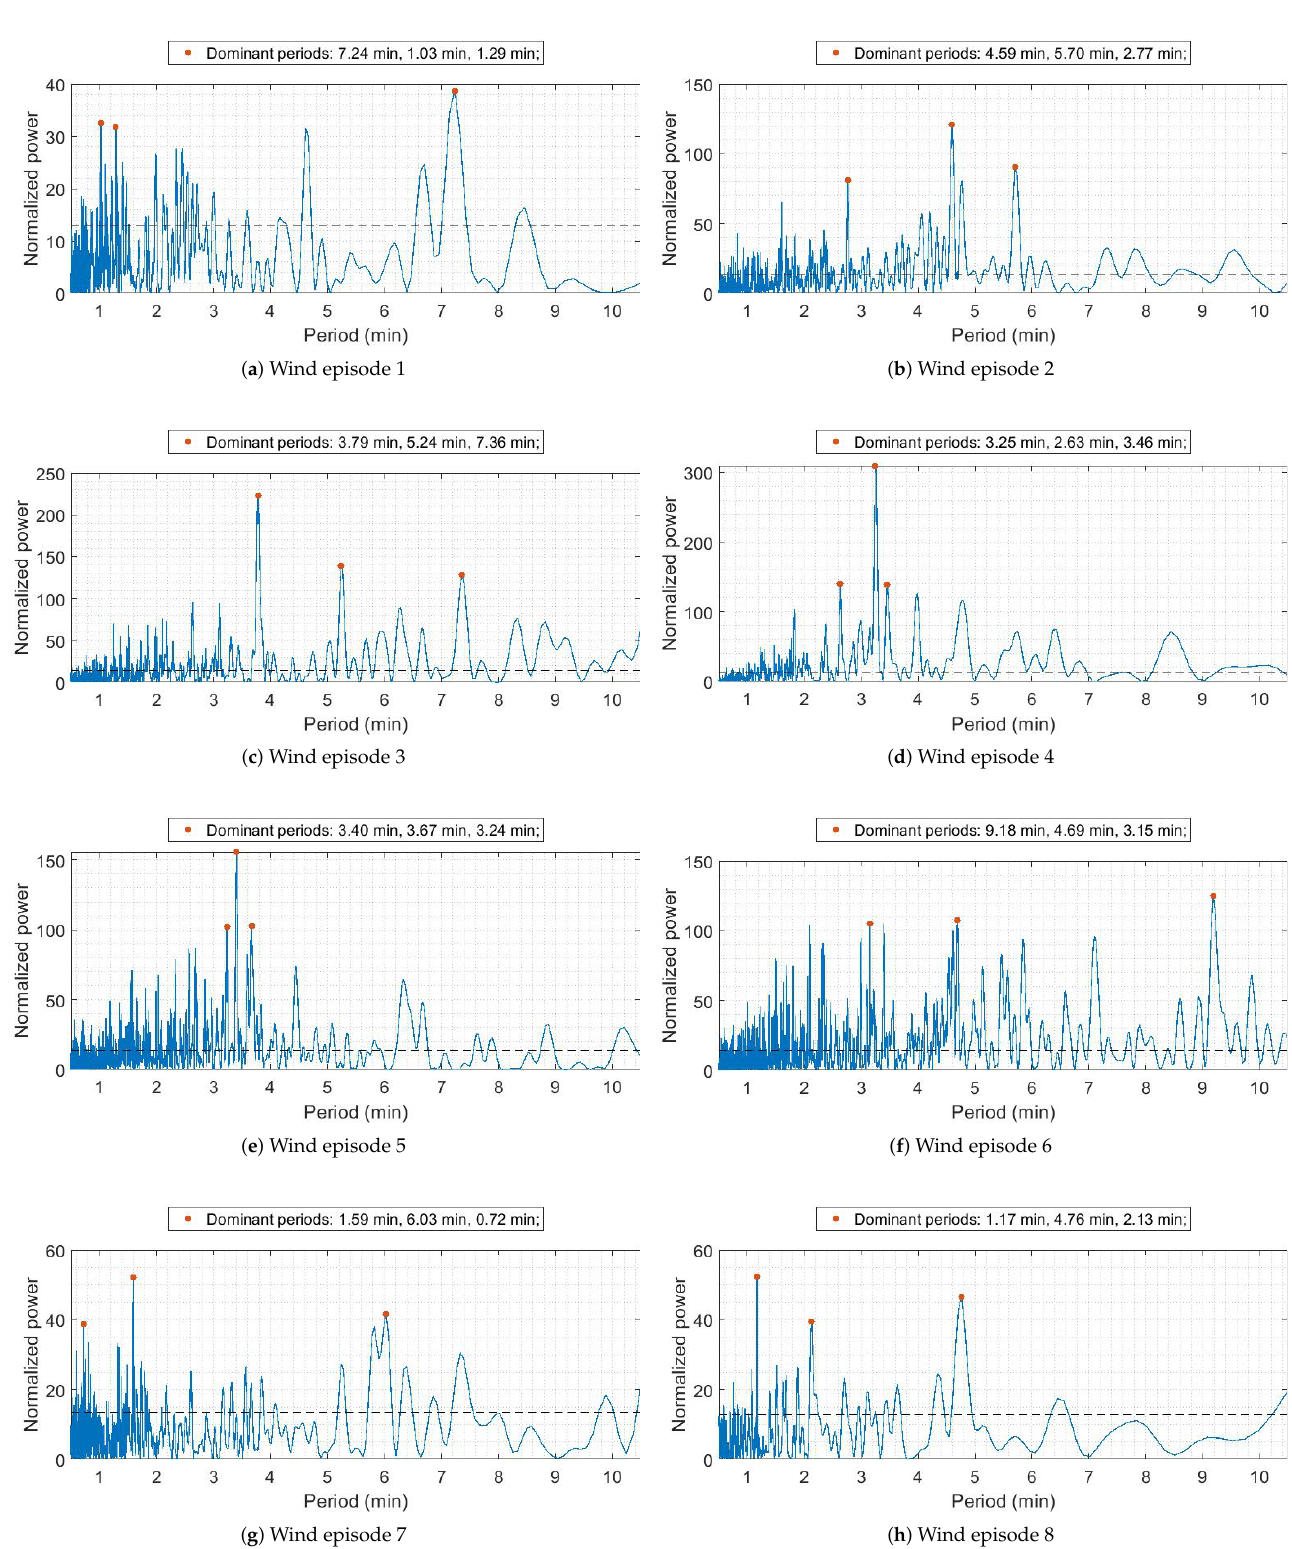
Figure 16. Periodograms of vertical wind speed, obtained at 110m AGL for all eight wind episodes. Horizontal black dashed line represents 0.001 significance level. Dominant periods are given in the legend for each